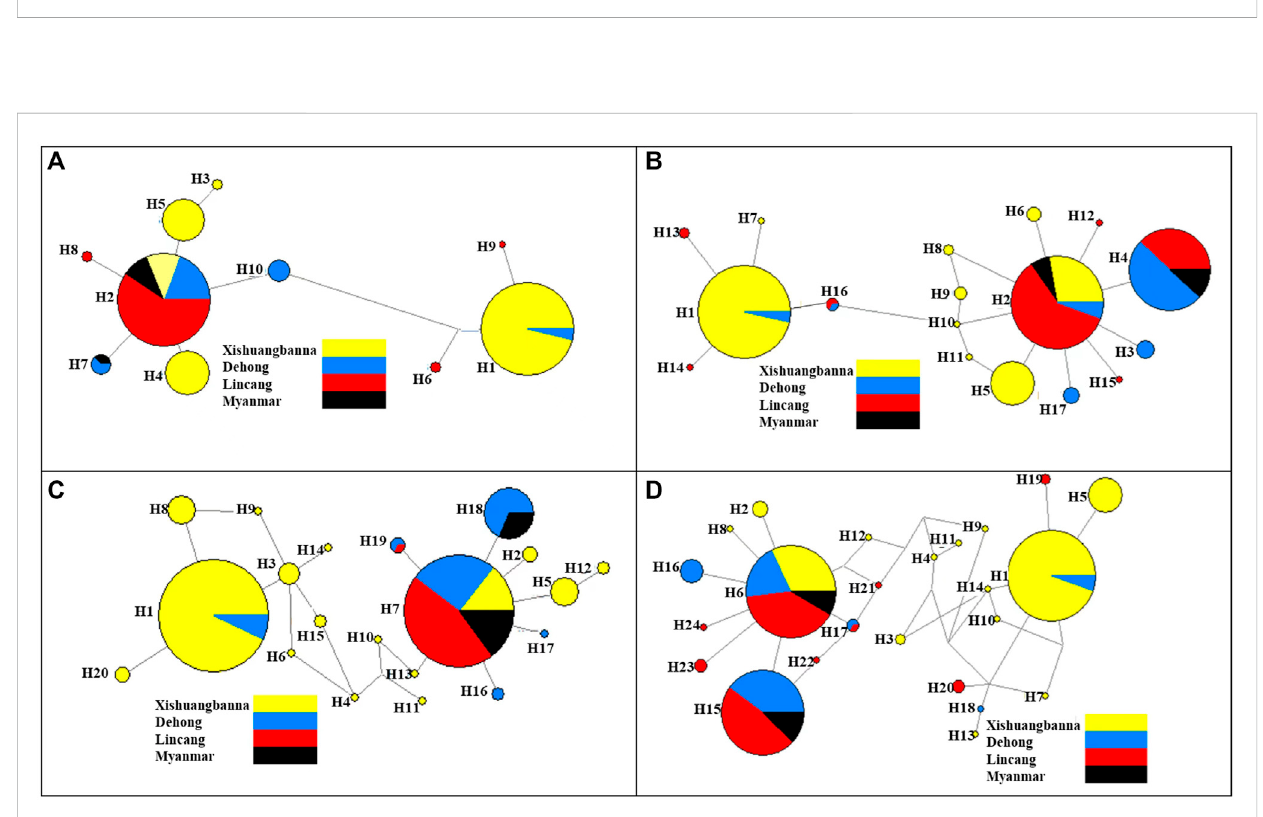
FIGURE 4 Analysis of the relationship between genetic distance [FST/(1-FST)] and geographical distance [ ㏑ (km)] for (A) 22 populations sampled in 2019 ( R 2 = 0.4806, p < 0.05) and (B) 17 populations sampled in 2020 ( R 2 = 0.4233, p < 0.05)